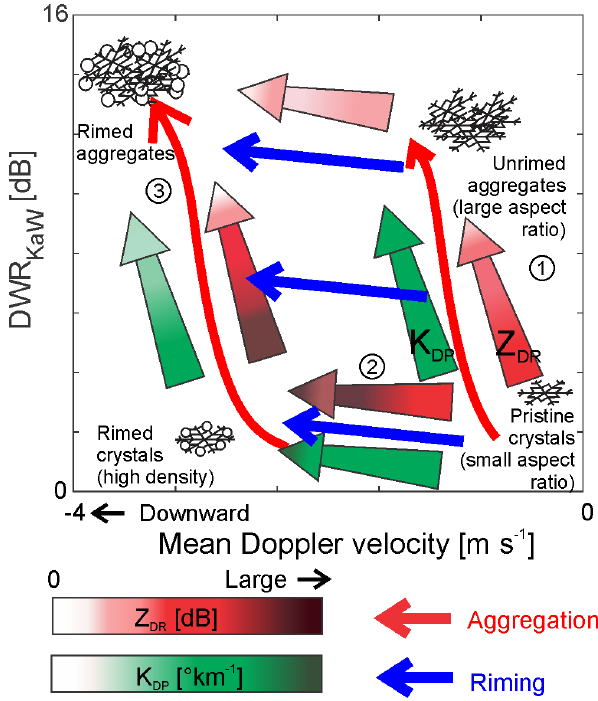
Figure 12. A schematic DWR–MDV–polarimetric variable diagram based on the observation in this